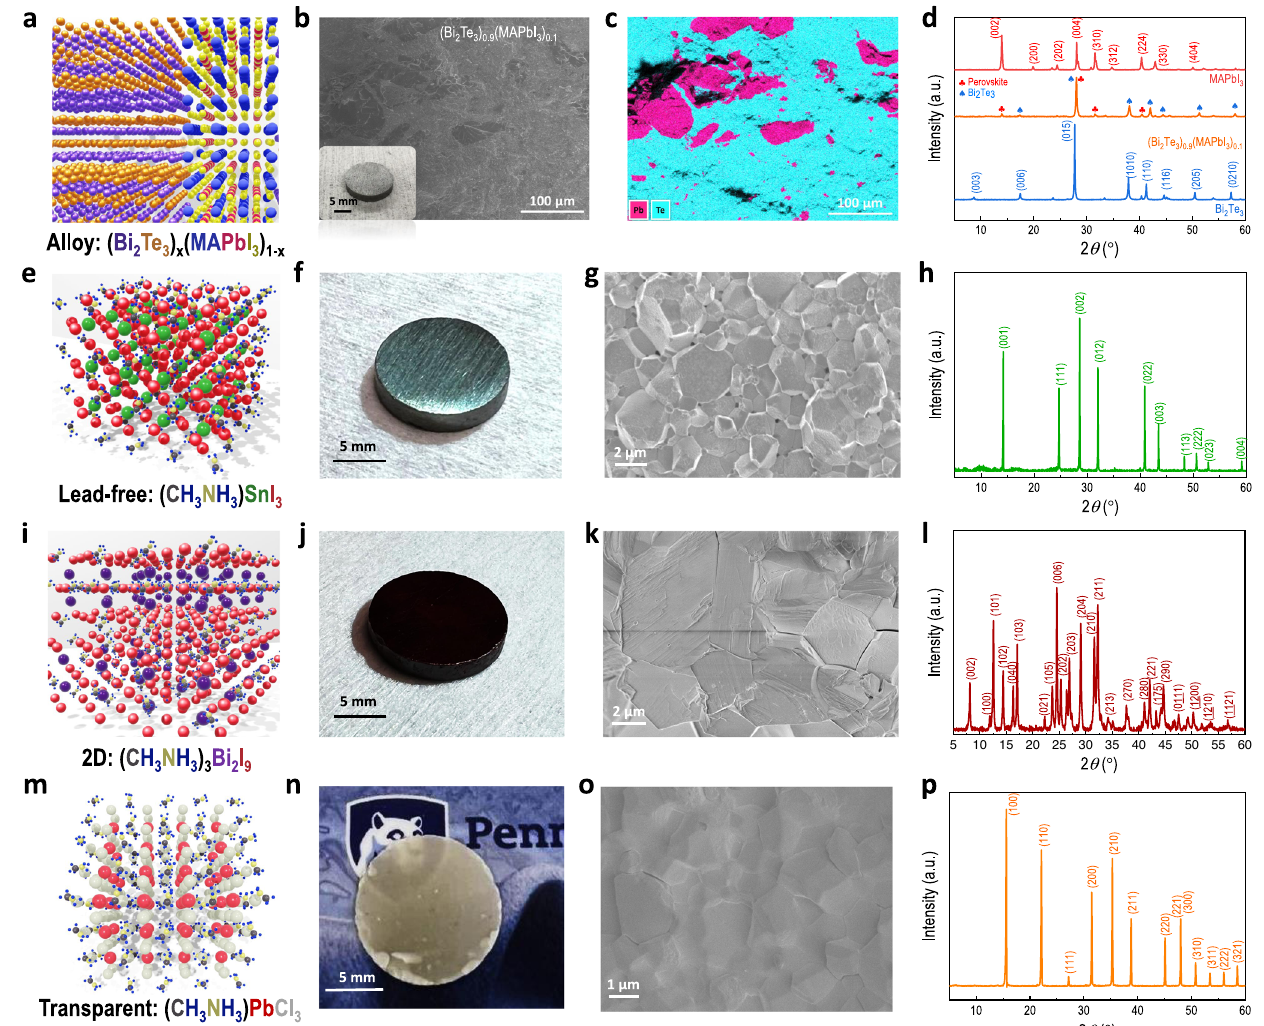
Fig. 4 | FAST compatibility to broader types of halide perovskites. Different compositions: (Bi 2 Te 3 ) x (MAPbI 3 ) 1 − x alloy: a scheme showing the con fi guration of the alloy lattice, where the atom is dressed in a color identical to that in the che- micalformula. b Cross-sectionalSEMimageoftheFAST-(Bi 2 Te 3 ) 0.9 (MAPbI 3 ) 0.1 with an inset of a photo of the FAST-(Bi 2 Te 3 ) 0.9 (MAPbI 3 ) 0.1 -disk sample. c EDS images displaying the perovskite phase (pink)dispersed in the Bi 2 Te 3 matrix (cyan),with a clear phase boundary. d XRD spectra of FAST-MAPbI 3 and FAST- (Bi 2 Te 3 ) 0.9 (MAPbI 3 ) 0.1 alloy, with comparison to that of Bi 2 Te 3 . The red club and blue spade represent the peak of MAPbI 3 and Bi 2 Te 3 , respectively. Lead-free per- ovskite of MASnI 3 : e atomic scheme showing the pseudo-cubic structure, with atomsbeingdressedinacoloridenticaltothatinthechemicalformula. f Photoofa